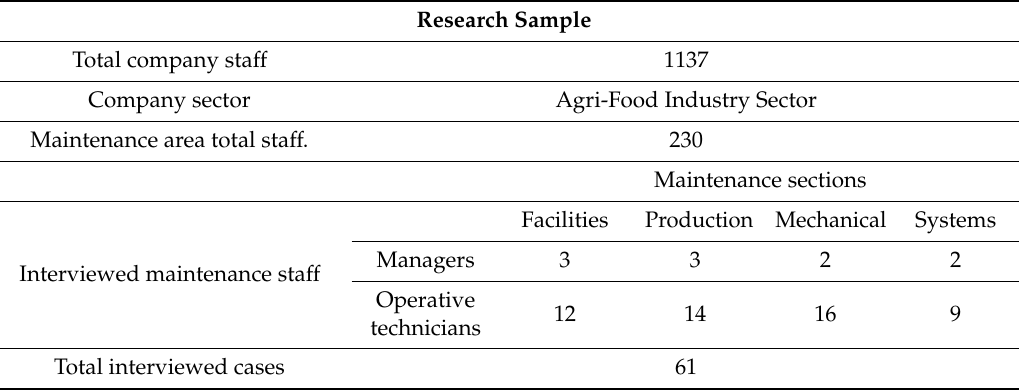
Table 1. Sample of qualitative